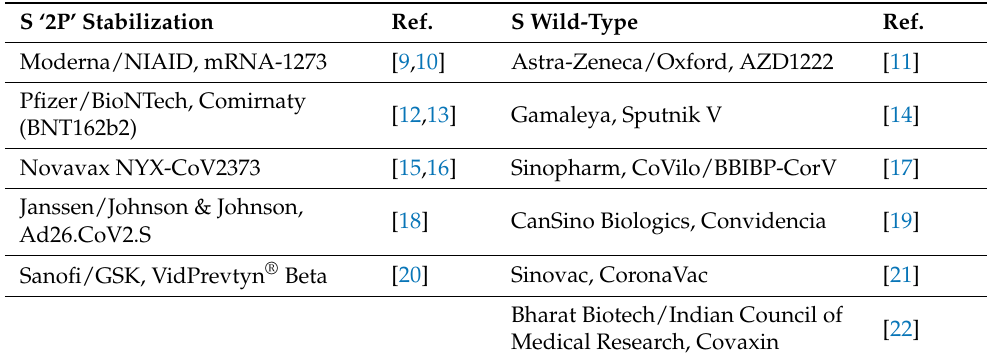
Table 1. SARS-CoV-2 vaccines authorized by national regulatory